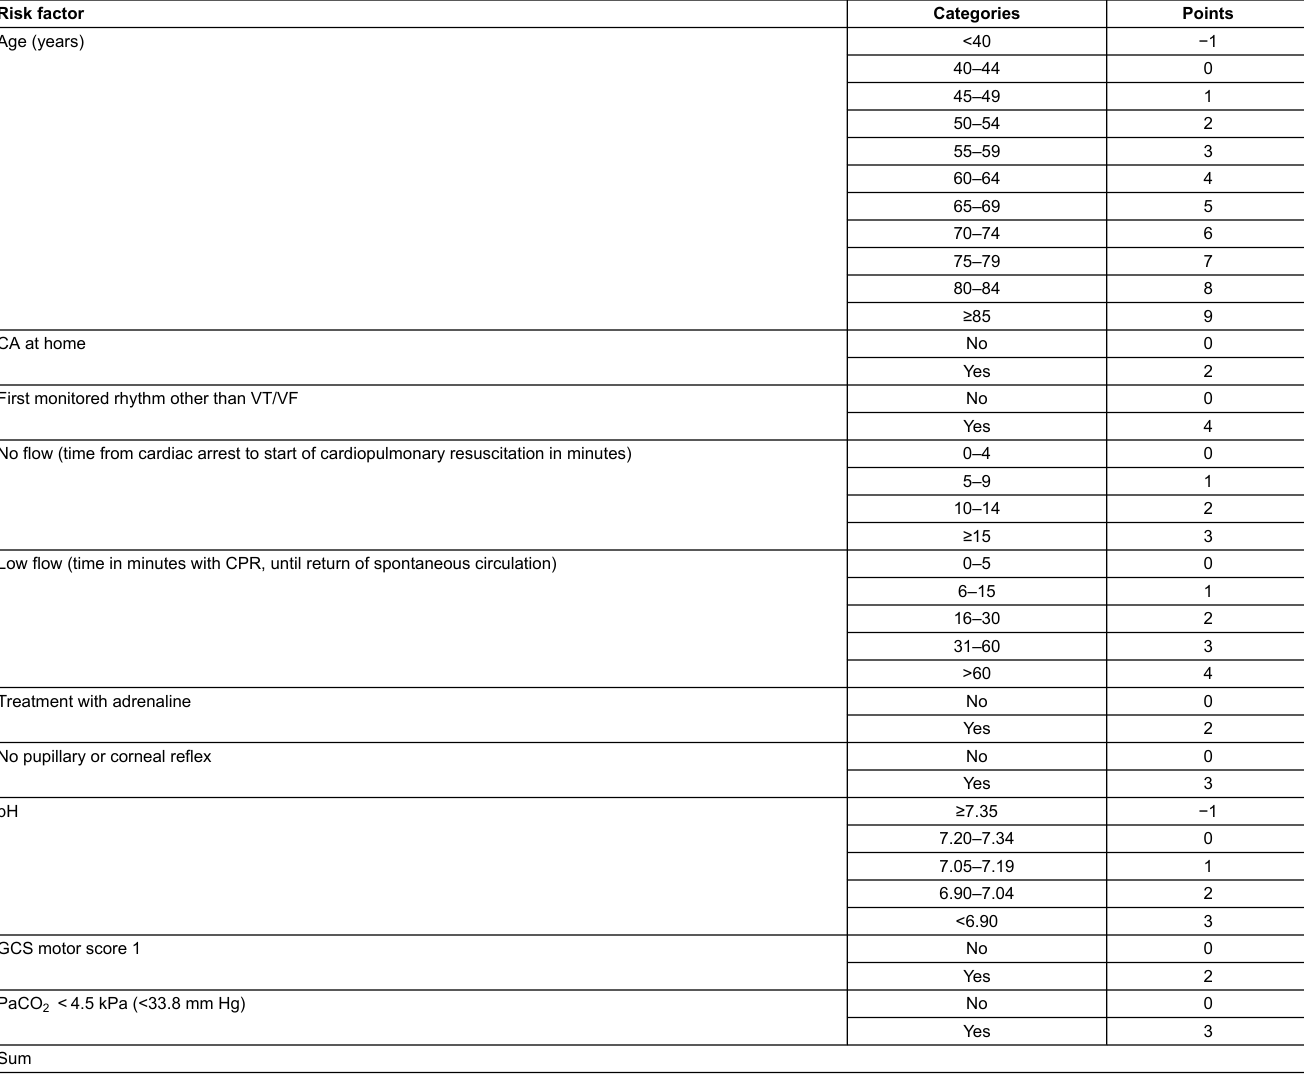
Table S1: Target Temperature Management risk score points (range −2 to